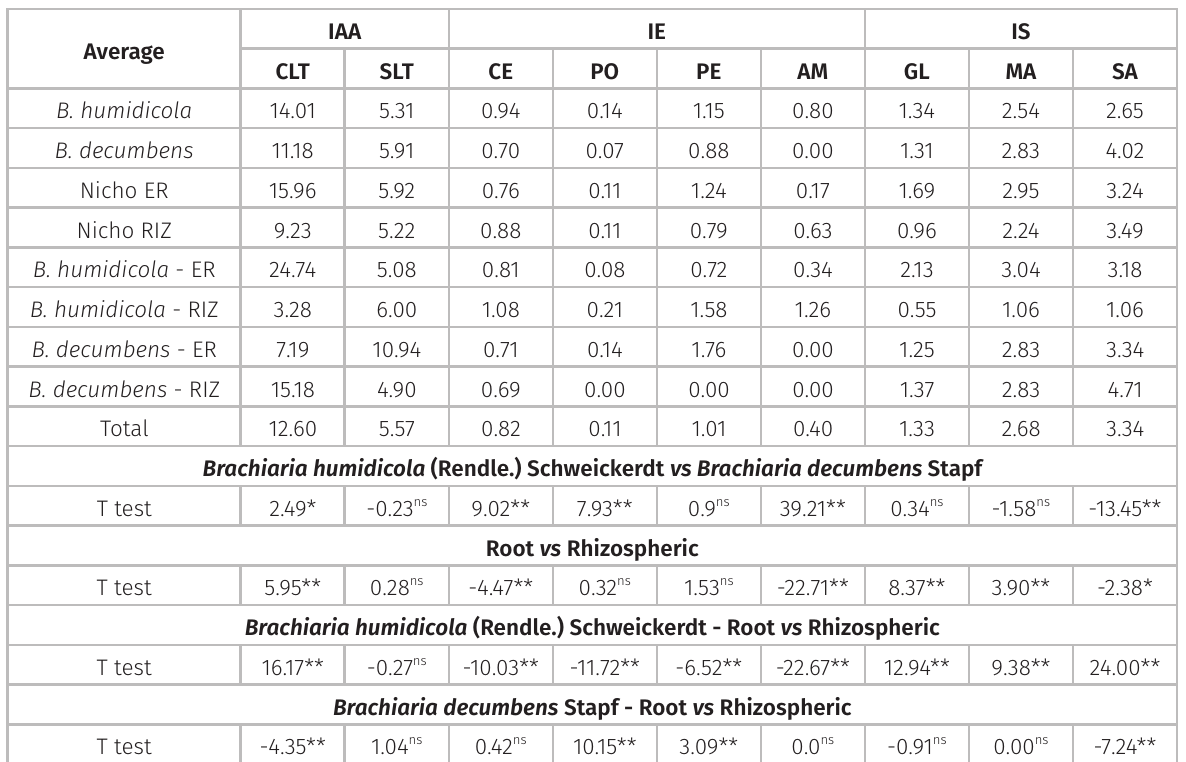
Table III. Comparison between groups of averages by orthogonal contrasts for the PGP mechanisms of 36 bacterial isolates associated with Brachiaria humidicola (Rendle.) Schweickerdt and Brachiaria decumbens Stapf. in endophytic root (ER) and rhizosphere (RI)